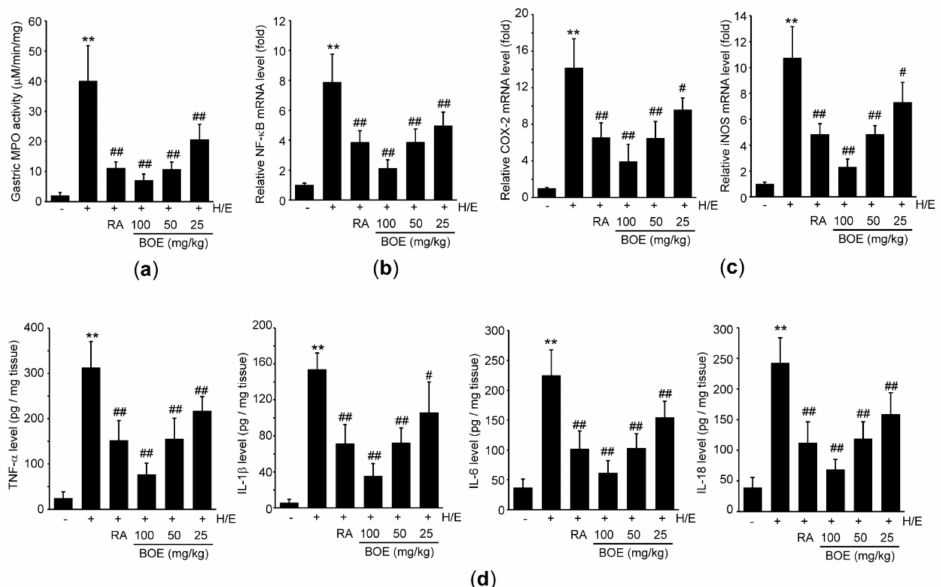
Figure 6. Effect of BOE on H/E-mediated inflammation in the gastric tissue. ( a ) Hydrogen peroxide and o -dianisidine dihydrochloride were used as substrates for detecting MPO activity in the gastric tissue. mRNA levels of NF- κ B and pro-inflammatory enzymes ( b ) and ( c ) and protein levels of pro-inflammatory cytokines ( d ) were determined by real-time PCR and ELISA, respectively. All numerical results are presented as mean ± SD of ten mice (** p < 0.01 between the vehicle and H/E groups; ## p < 0.01, # p < 0.05 versus H/E-administered group). BOE, B. oleracea var. capitata L. extract; COX-2, cyclooxygenase-2; H/E, HCl/ethanol; IL, interleukin; iNOS, inducible nitric oxide synthase; MPO, myeloperoxidase; NF- κ B, nuclear factor- κ B; RA, ranitidine hydrochloride; TNF, tumor necrosis factor.